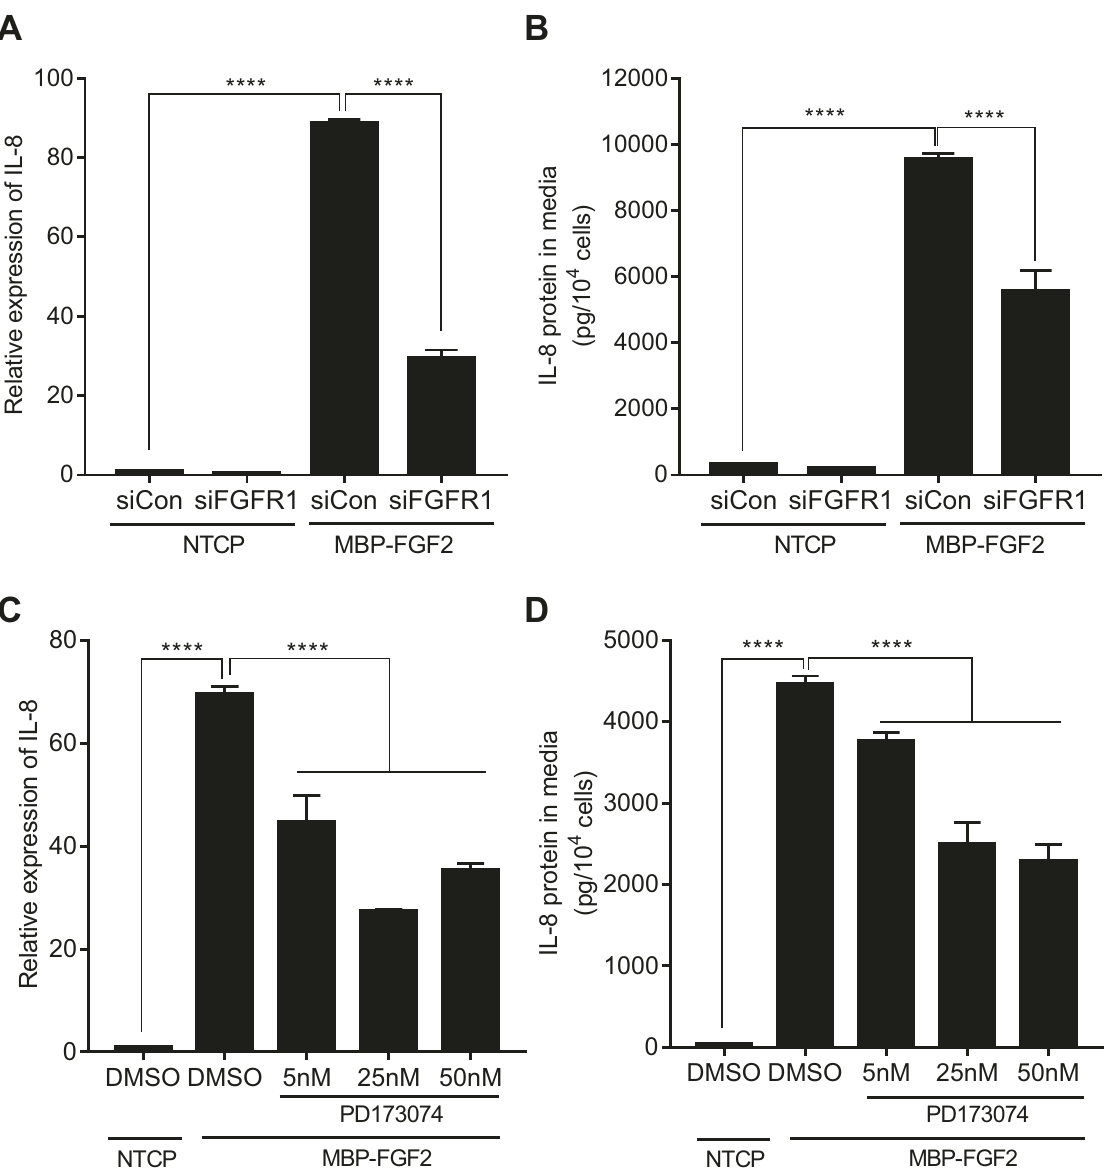
Fig. 3 Roles of FGFR1 on the MBP-FGF2-mediated IL-8 expression. hASCs were treated with FGFR1 siRNA or PD173074, an FGFR1 inhibitor, and cultured on NTCP or MBP-FGF2 surface for 24 h. Total RNA and conditioned medium were prepared and analyzed by RT-qPCR and ELISA, respectively. A Effect of FGFR1 knockdown on IL-8 RNA. B Effect of FGFR1 knockdown on IL-8 protein. C Effect of PD173074 on IL-8 RNA. D Effect of PD173074 on IL-8 protein. For all data, **** p < 0.0001 (one-way ANOVA), n = 3 per group. Values were normalized to GAPDH for RT- qPCR analysis. All data are presented as mean ±